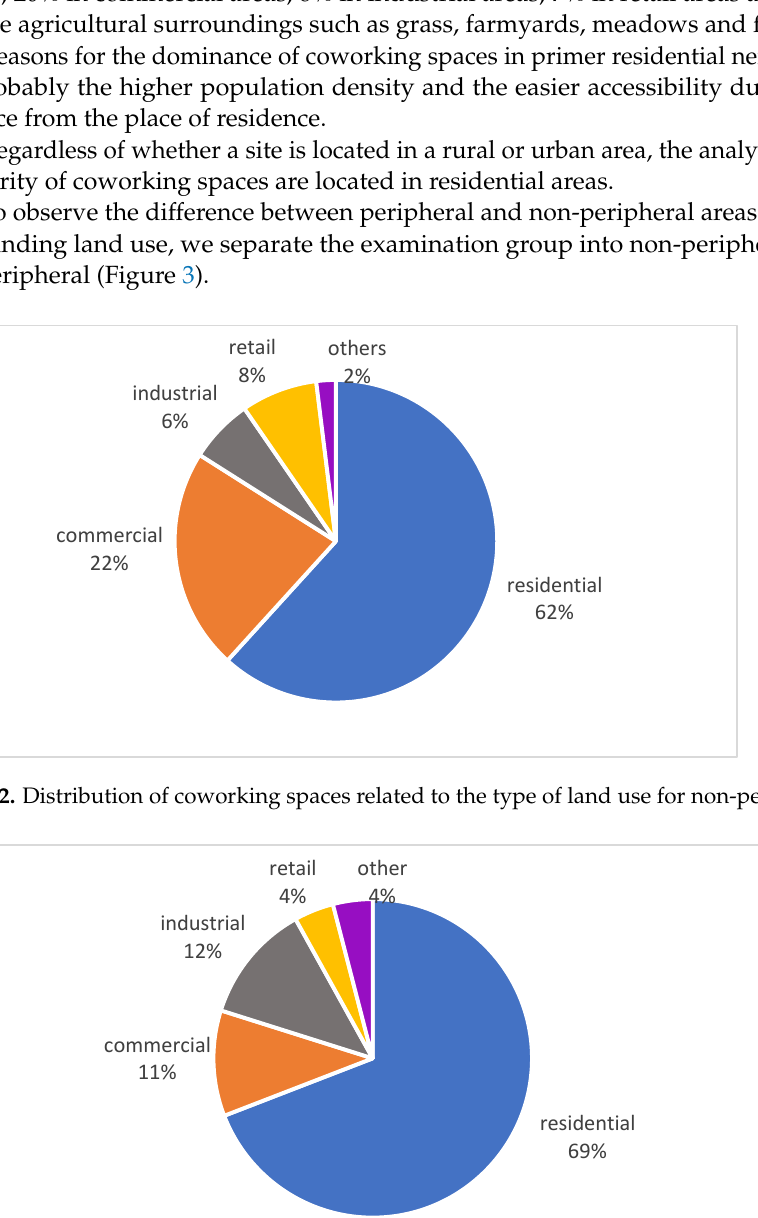
Figure 3. Distribution of coworking spaces related to the type of land use for peripheral areas.